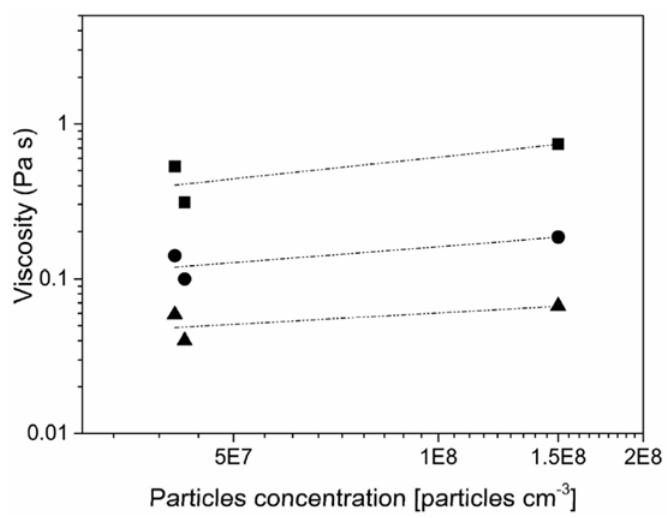
Figure 4. Viscosity as a function of particles concentration (triangles: SR 100 s − 1 ; circles: SR 10 s − 1 ; squares: SR 1 s − 1 ).